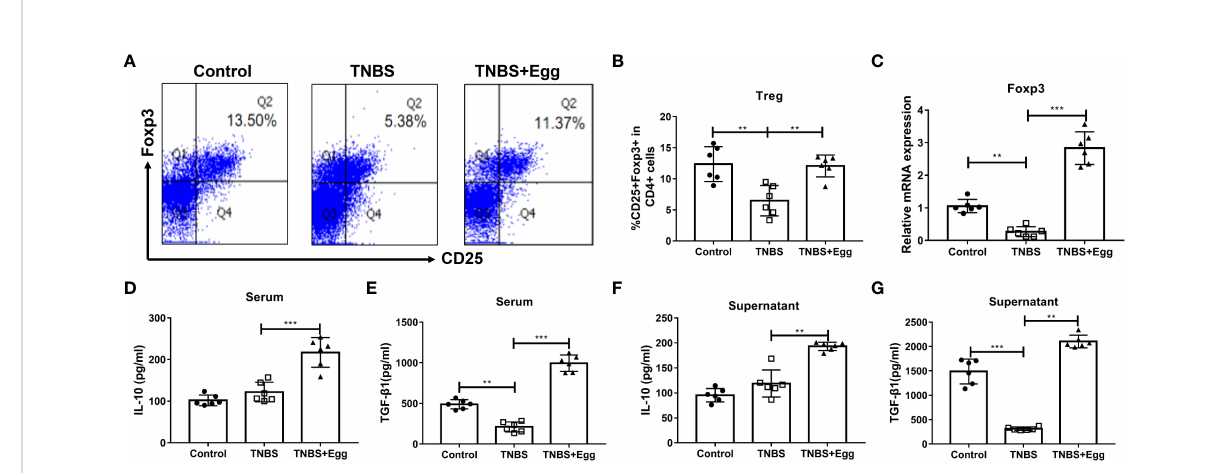
FIGURE 2 Pre-exposure to S. japonicum eggs upregulated Treg immune response in the TNBS-induced experimental colitis. (A, B) The proportion of CD25+Foxp3+Treg in CD4+ T cells in spleen. (C) The mRNA expression level of Foxp3. The concentrations of IL-10 and TGF- b 1 in serum ( D, E , respectively) and in splenic supernatants ( F, G , respectively). Data are expressed as means ± SEMs based on 6 mice in each group and from 2 independent experiments. Asterisks mark signi fi cant differences among different groups (** P < 0.01, *** P <